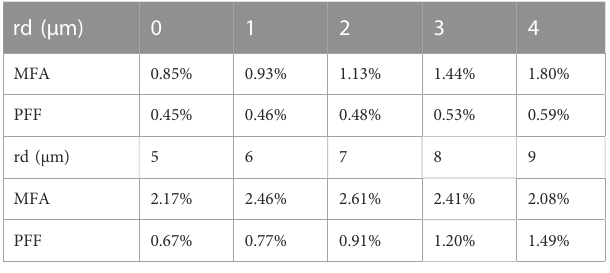
Figure 8A, the bending loss of FM is smaller than 0.1 dB/m for relatively small dip parameters (e.g., Dn < 0.0005 and r d < 4 μ m) and (e.g., Dn > 0.0008 and r d > 7 μ m). Meanwhile, the bending loss of